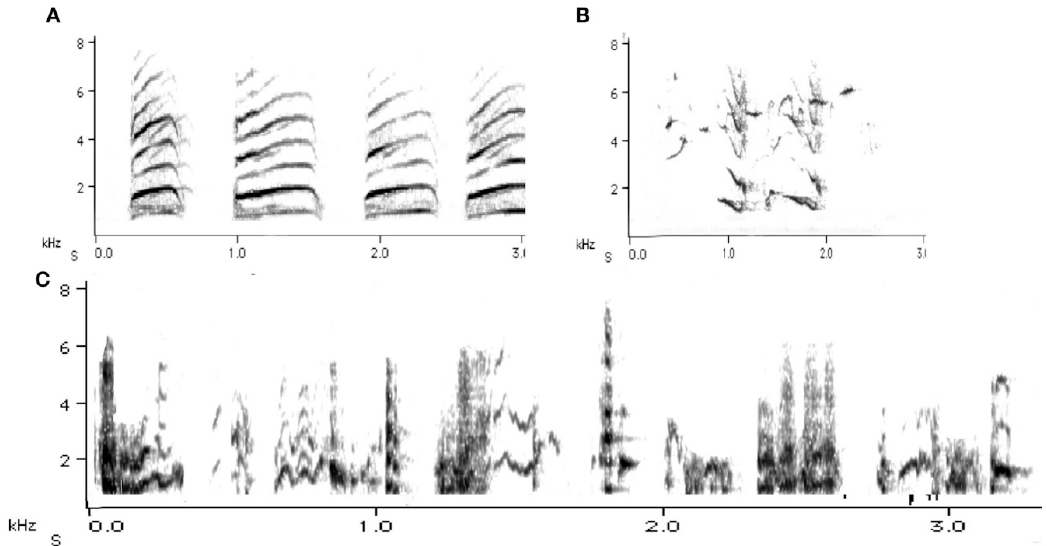
Figure 2. Juvenile vocal expression at fledging. ( A ) Begging call: stereotyped and of high frequency. ( B ) Affective (impulsive), spontaneous sounds (chaotic): expression of fear and distress. ( C ) Well-practised vocal expressions: evidence of the beginnings of a sizeable song repertoire .